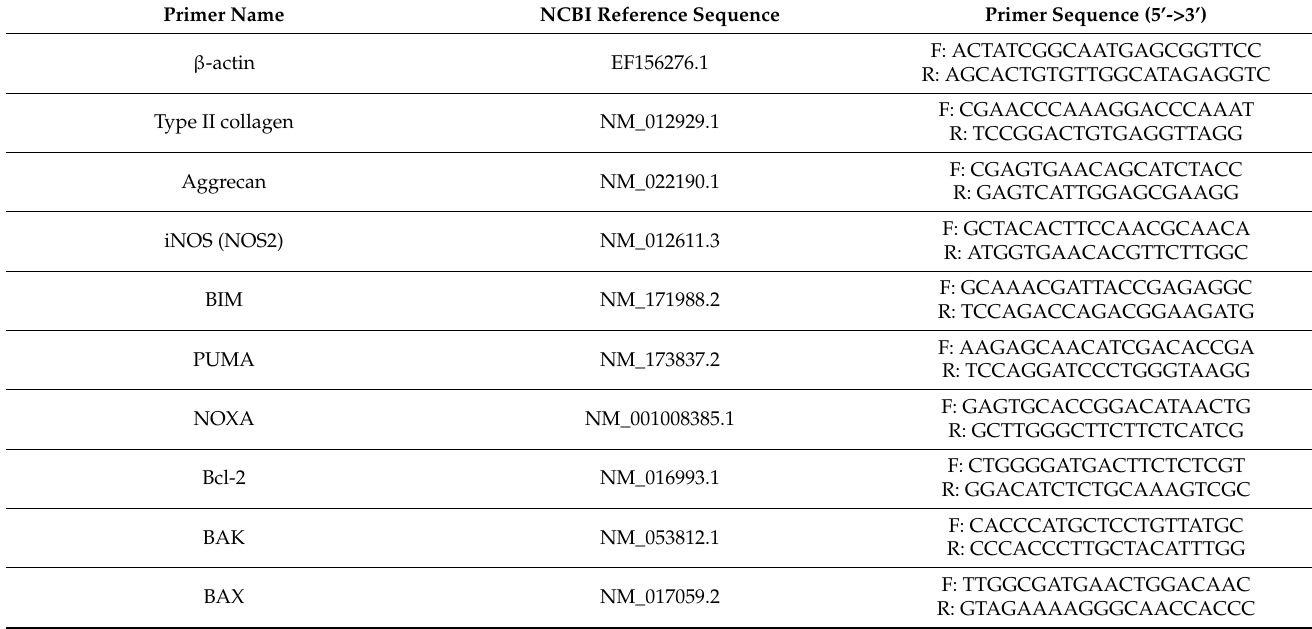
Table 1. Primer sets for qPCR